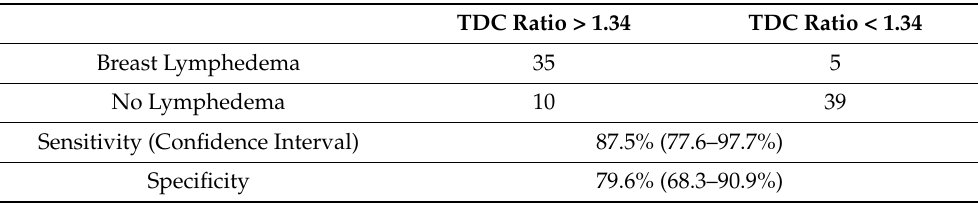
Figure 3. ROC curve for TDC ratio. Table 8. Sensitivity and specificity of TDC ratio at 1.34 threshold